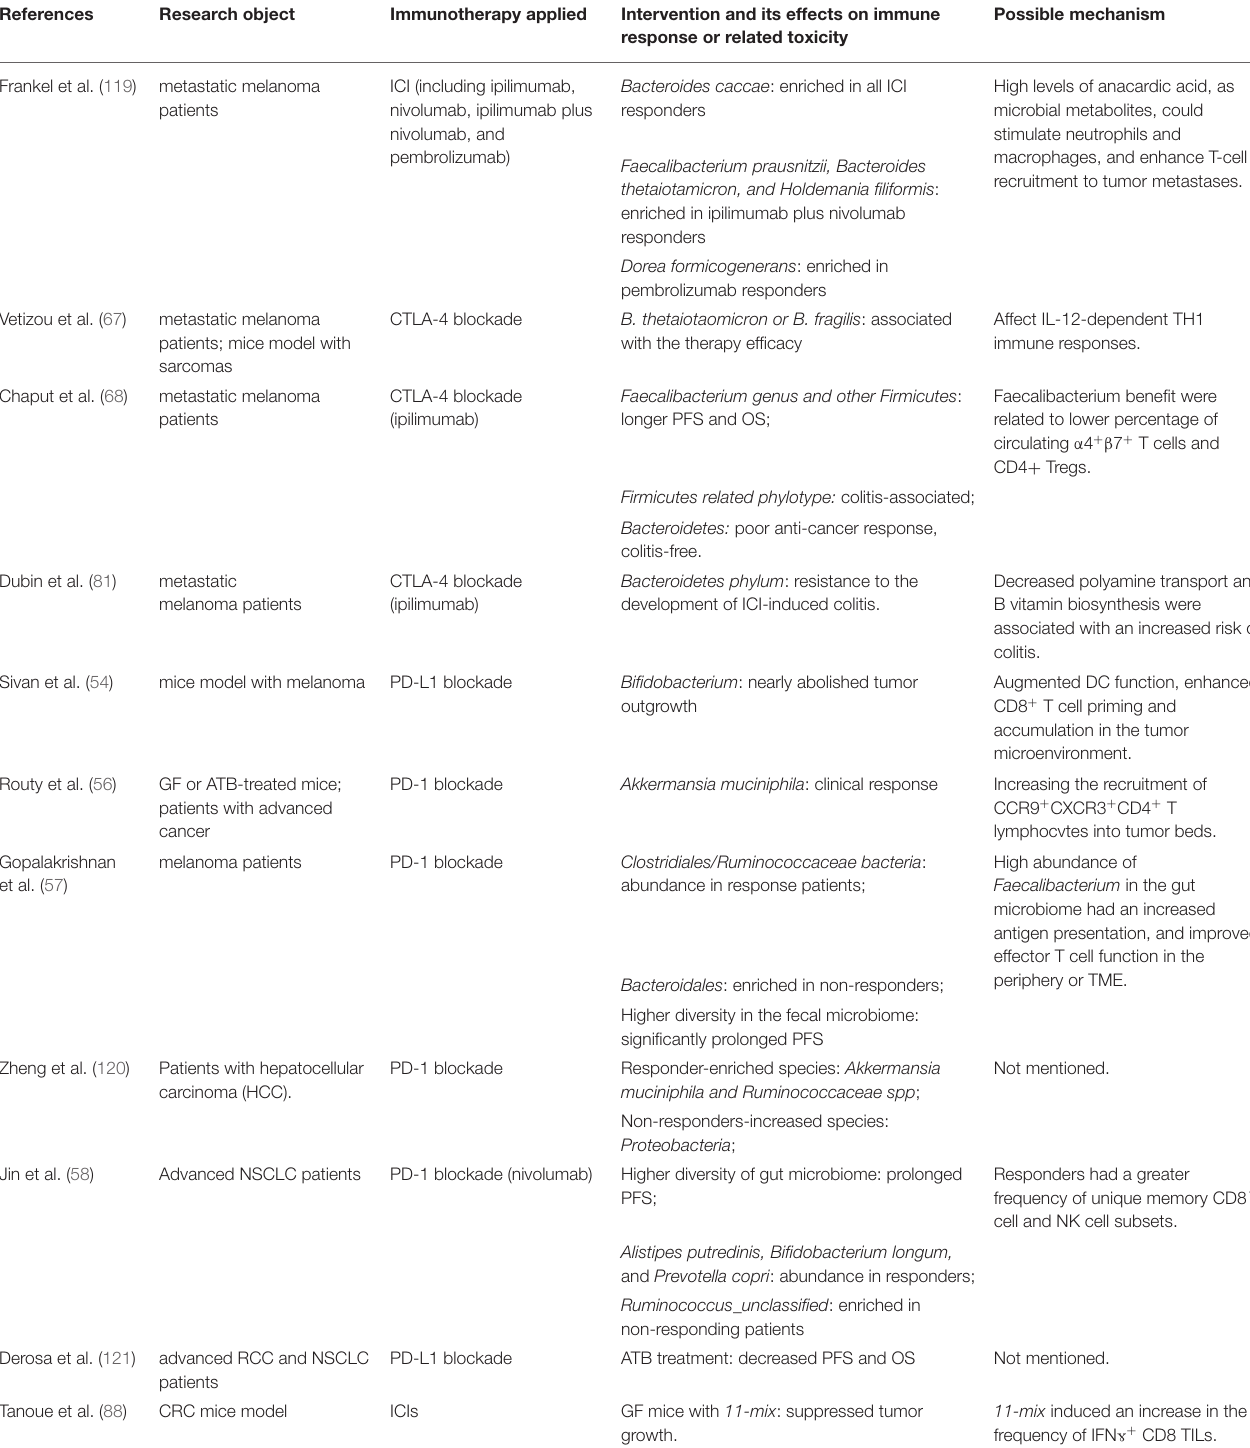
TABLE 1 | Recent studies about the regulation of immunotherapy response or related toxicity by targeting gut